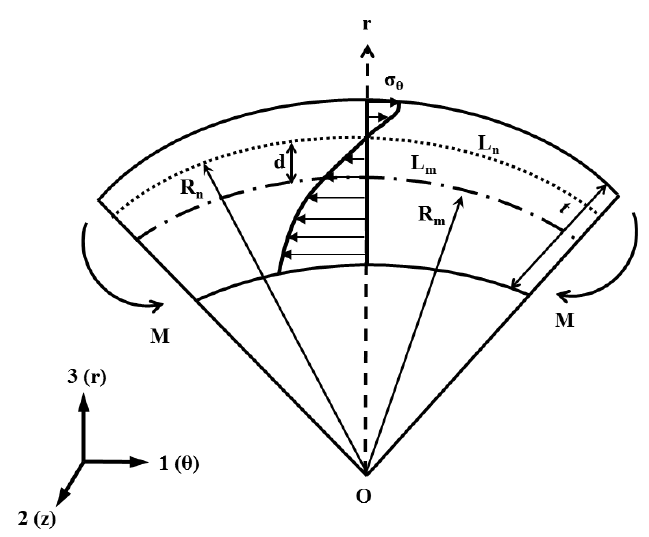
Figure 1. Schematic diagram of stress distributions with the curvature through the sheet thickness.